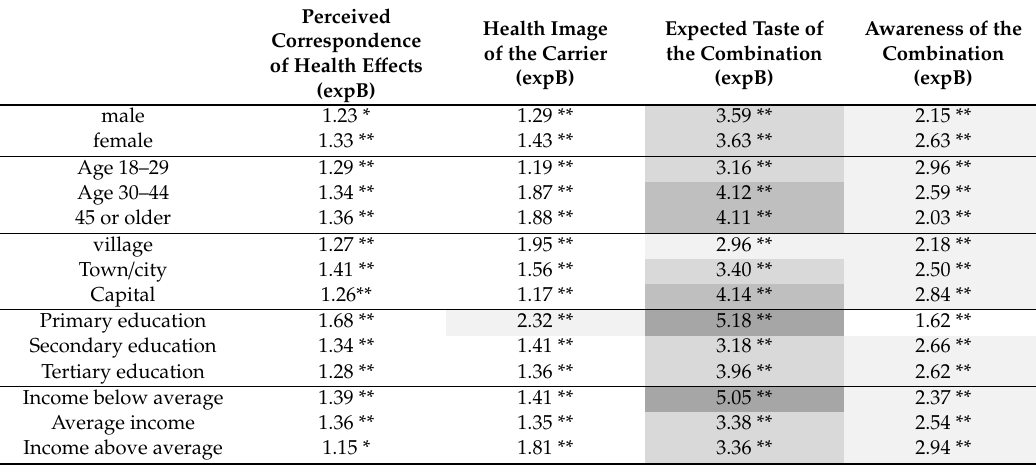
Table 5. The influence of individual factors on the perceived fit of carrier / ingredient combinations in di ff erent demographic